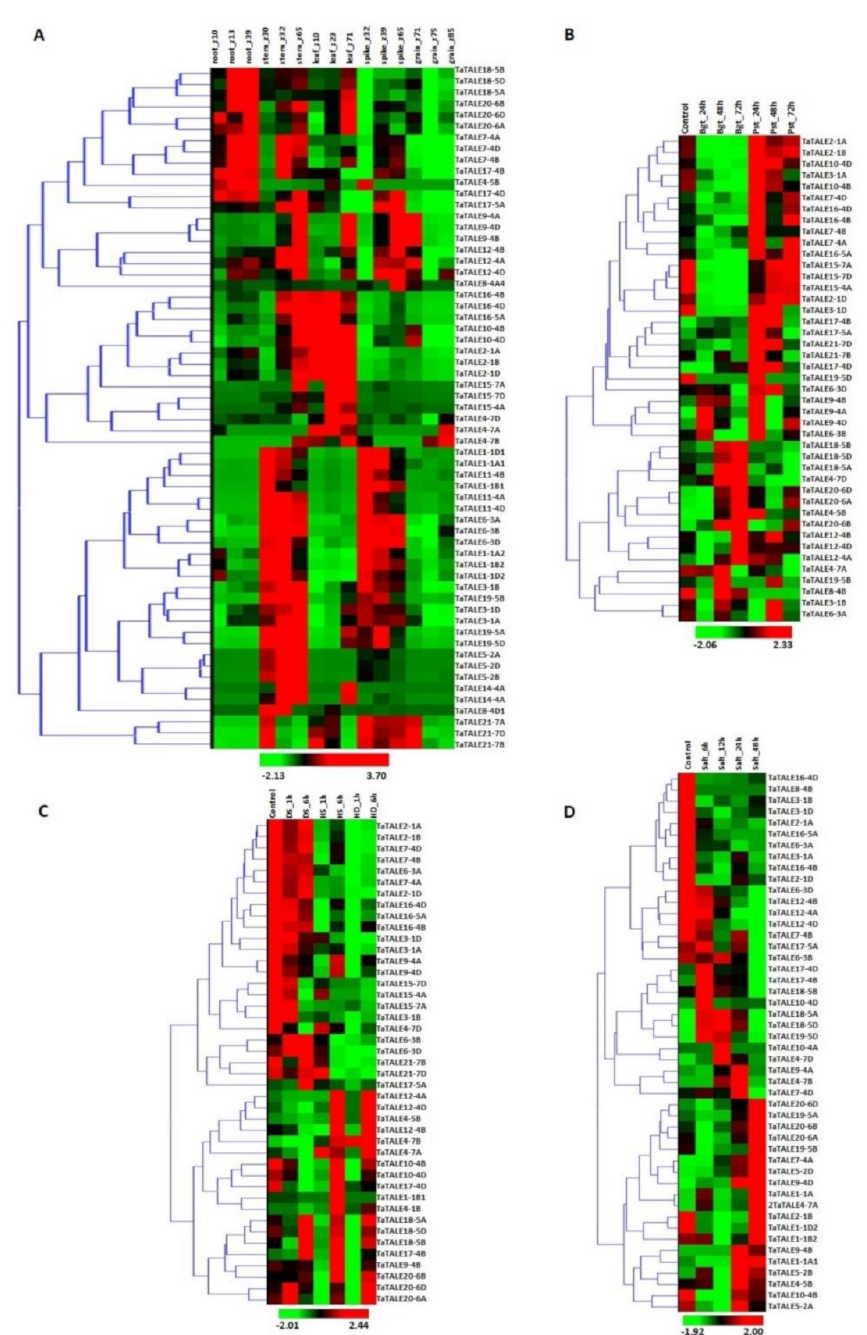
Figure 5. Expression analysis of TaTALE genes. The figure shows the expression profiling of TaTALE genes in ( A ) various tissue developmental stages represented by the Zadoks scale, ( B ) under biotic stress, ( C ) under heat (HS) drought (DS) and their combination (HD) stresses, and ( D ) under salt stress